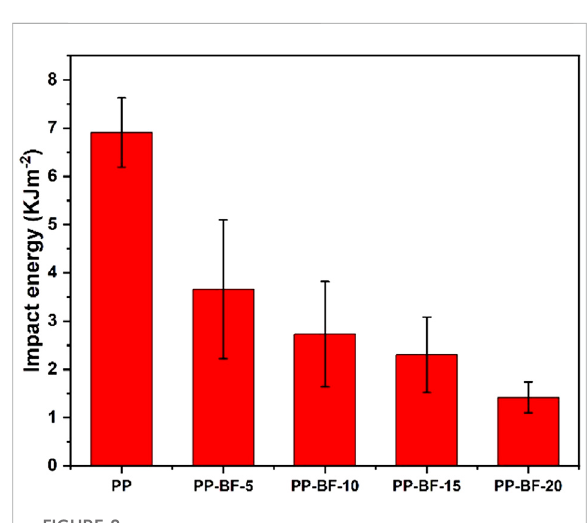
FIGURE 8 Impact properties of BF reinforced PP composites at various fi ber content. With the addition of BF content, impact strength of the composite